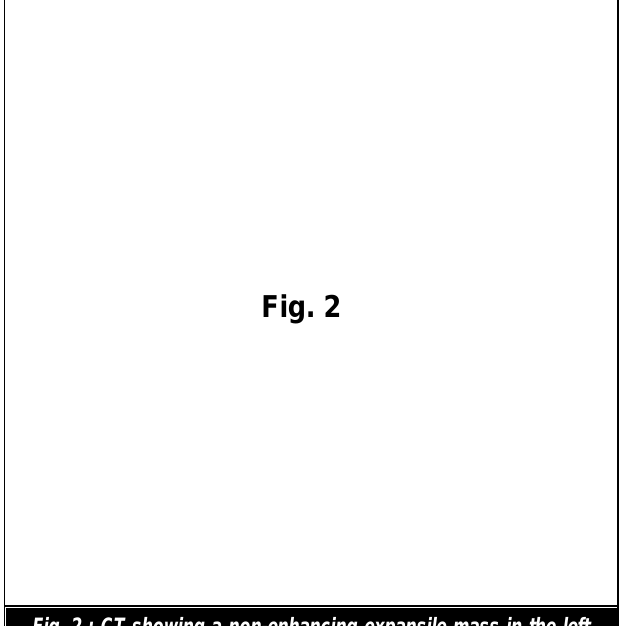
Fig. 2 : CT showing a non-enhancing expansile mass in the left maxillary antrum. (Fig 2). Relevant documents of me previous surgical procedures were not available. An FNAC from the swelling showed features suggestive of a benign infected cyst. Laboratory